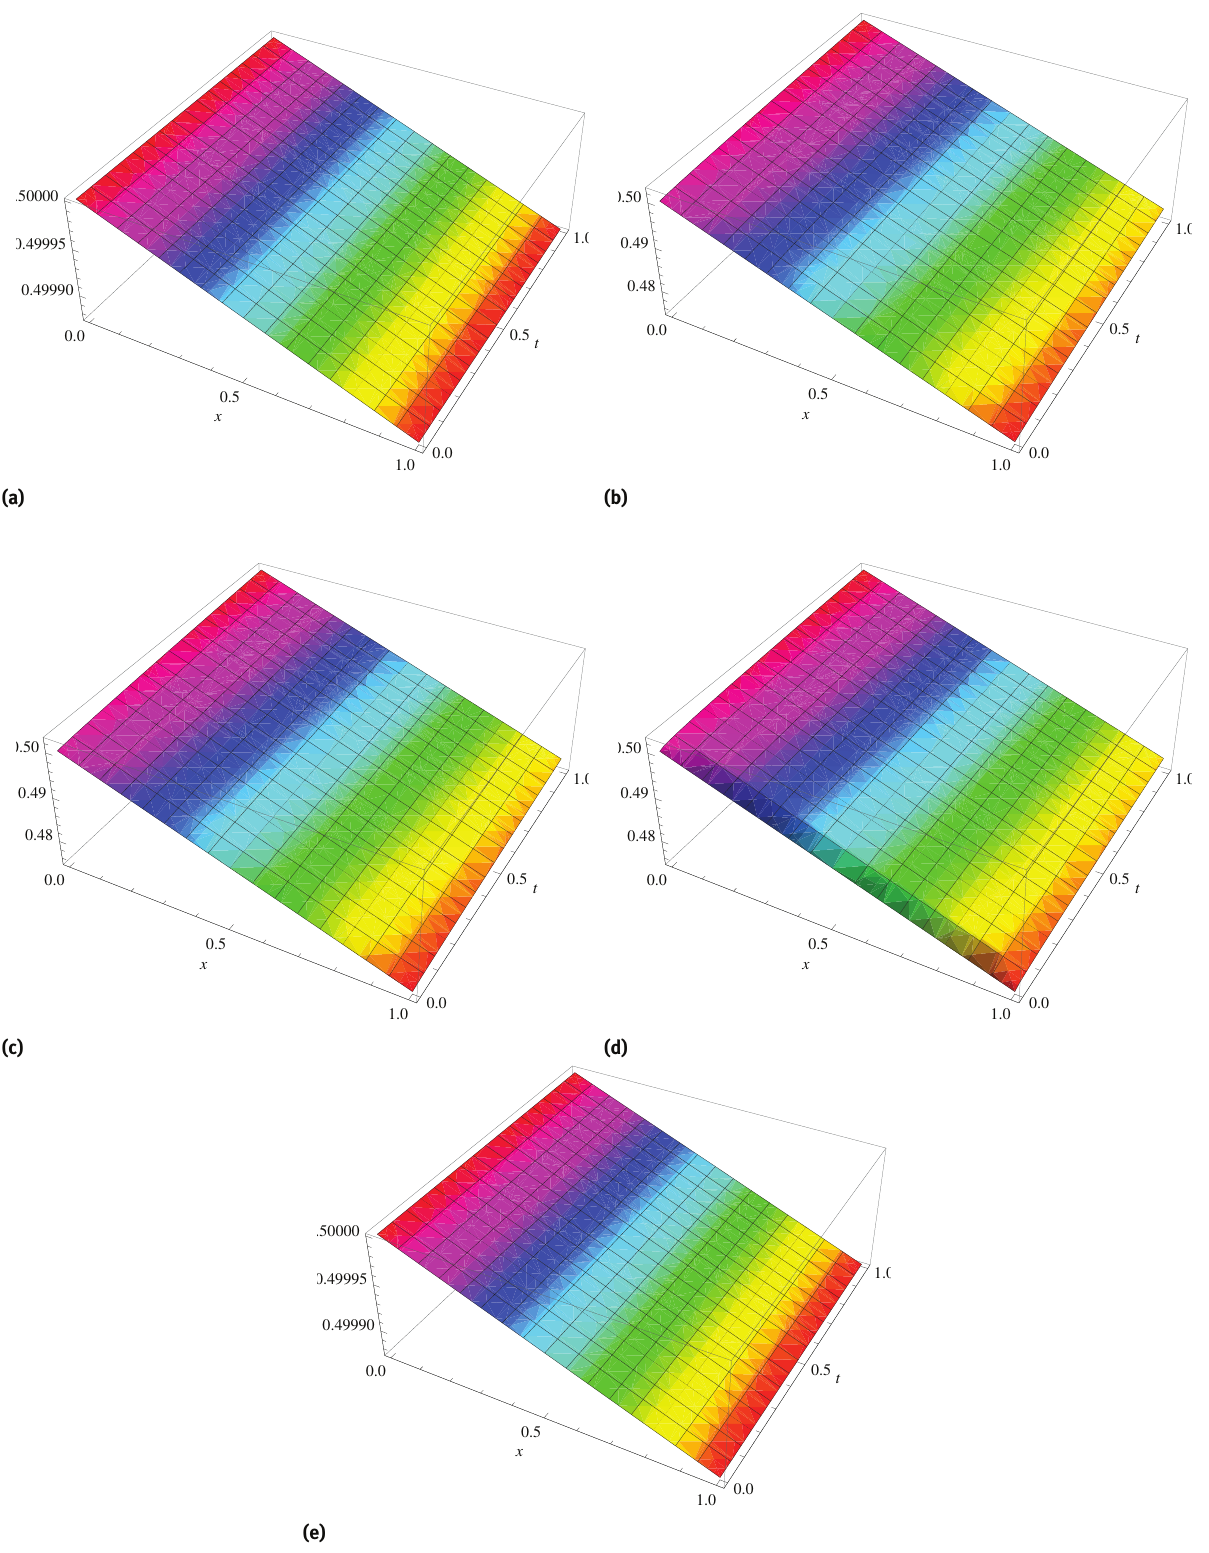
Fig. 12: Surface shows the 3rd order approximate solution of the time- fractional Fisher equation: (a) u 3 ( x , t ) when α = 1 , (b) u 3 ( x , t ) when α = 0.75 , (c) u 3 ( x , t ) when α = 0.5 , (d) u 3 ( x , t ) when α = 0.25 , (e) Exact solution u ( x , t ) when α = 1